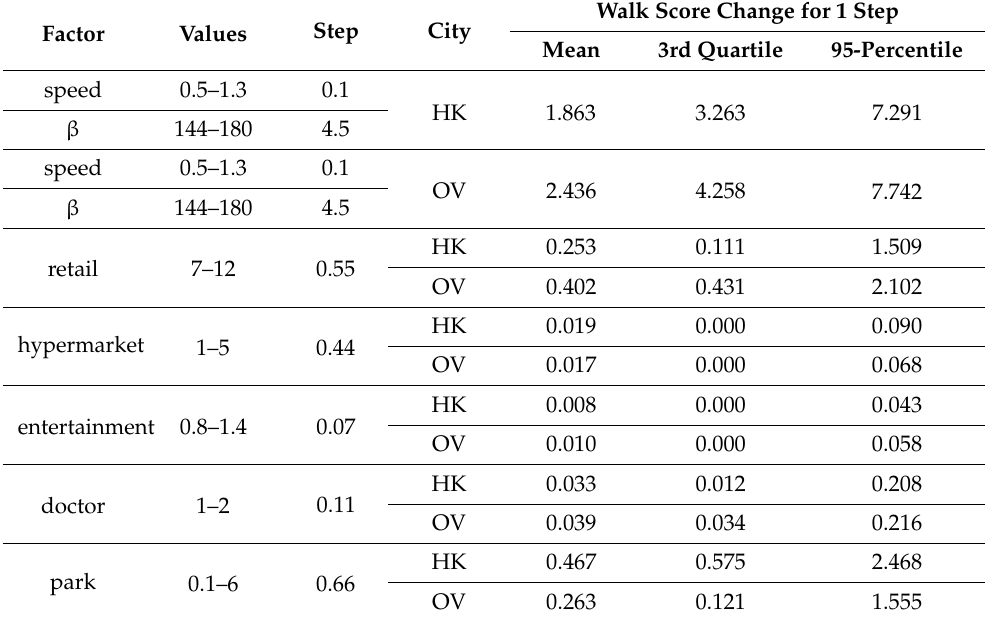
Table 5. Impact of one step modification of weights to changes in WS for elderly.